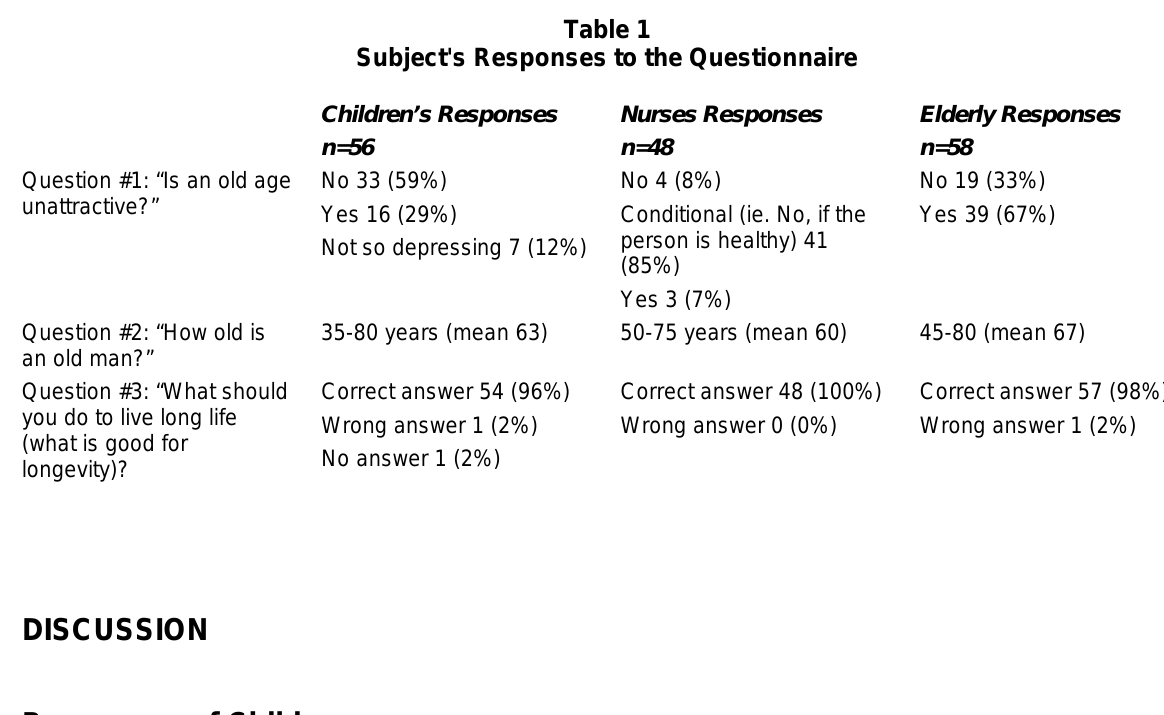
Subject's Responses to the